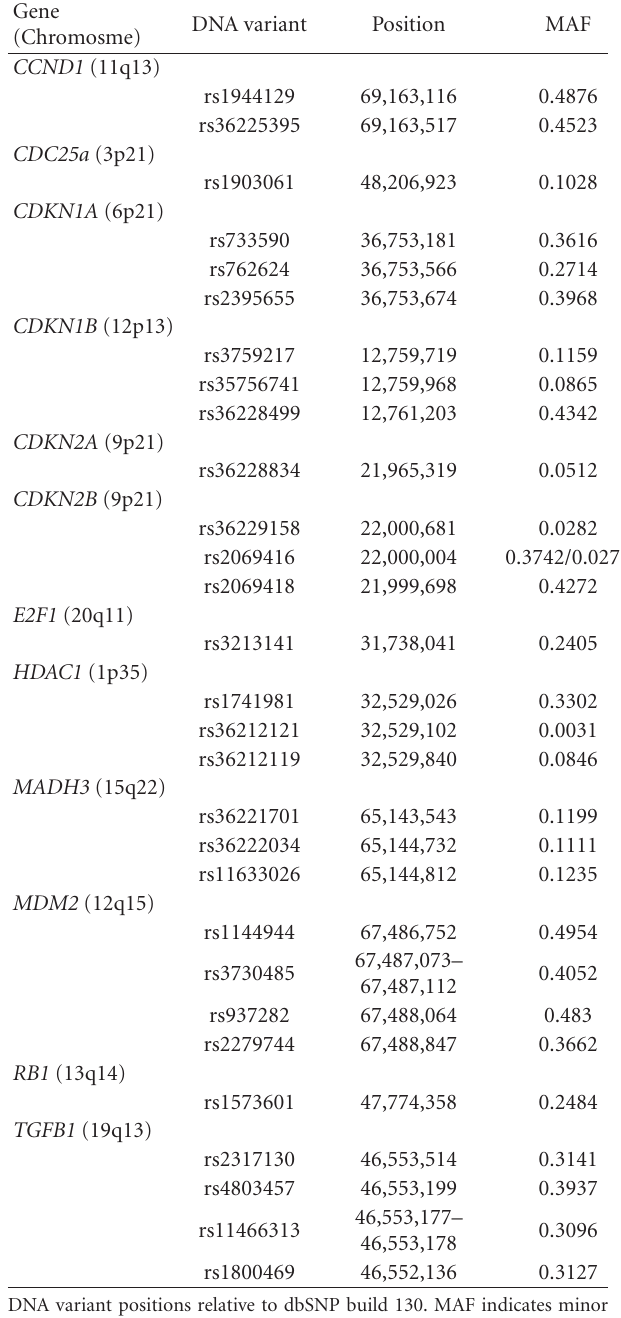
Table 4: Genes and DNA variants genotyped in the pre-B ALL association